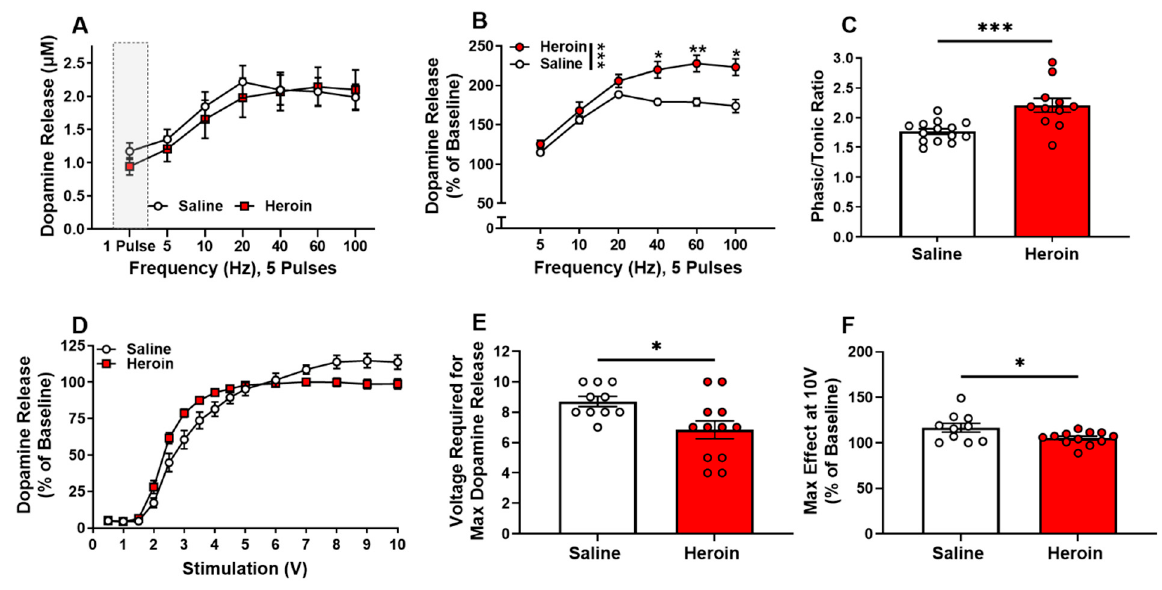
Figure 5. Heroin self-administration alters the dynamic range of dopamine release. Dopamine release was evoked with five pulses at increasing frequencies (5–100 Hz). ( A ) The magnitude of dopamine release did not differ between heroin-exposed and saline animals. ( B ) Percent dopamine release was significantly greater in heroin-exposed rats at high frequencies. ( C ) The multi-pulse phasic/tonic ratio was significantly greater in heroin-exposed rats than in saline control rats. ( D ) Dopamine release following single-pulse electrical stimulation of low and high intensities. Percent dopamine release was significantly greater at low (2.5–4 V) stimulation intensities and was significantly lower at high (7–10 V) stimulation intensities in heroin-exposed rats. ( E ) The stimulation amplitude needed to elicit the greatest dopamine release was reduced in heroin-exposed rats. ( F ) The maximal release by the 10 V stimulation was significantly decreased in heroin-exposed rats. * p < 0.05; ** p < 0.001; *** p < 0.001.